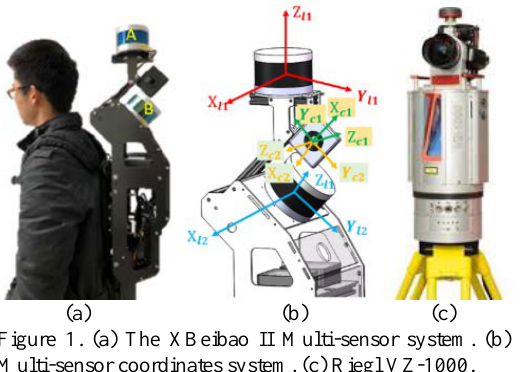
Figure 1. (a) The XBeibao II Multi-sensor system. (b) Multi-sensor coordinates system. (c) Riegl VZ-1000.